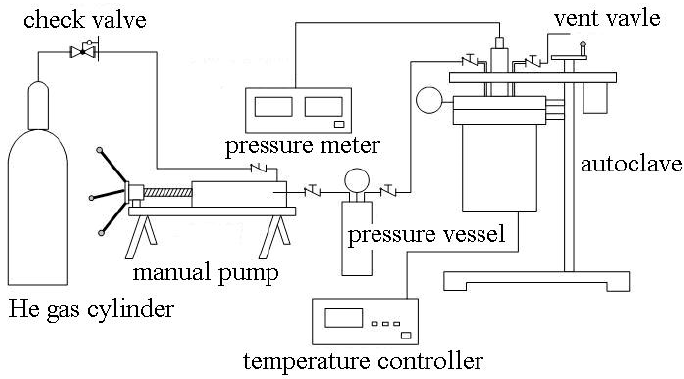
Figure 1. The schematic diagram of the experimental system for synthesizing coal samples.